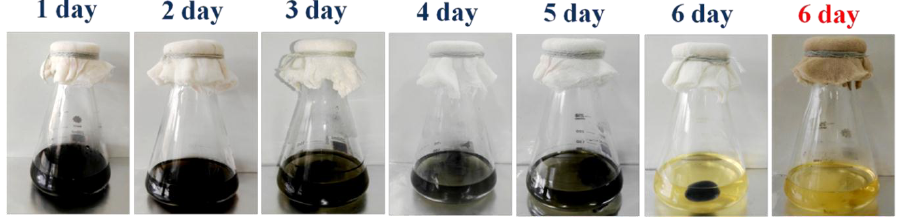
Figure 3. Growth of bacterial cellulose in the presence of c-MWCNTs (50 mg/100 mL) sheets: Photographic image of the six day track of bacterial cellulose growth in presence of c-MWCNTs under agitated conditions. The sixth day growth of bacterial cellulose in the absence of c-MWCNTs (red font).